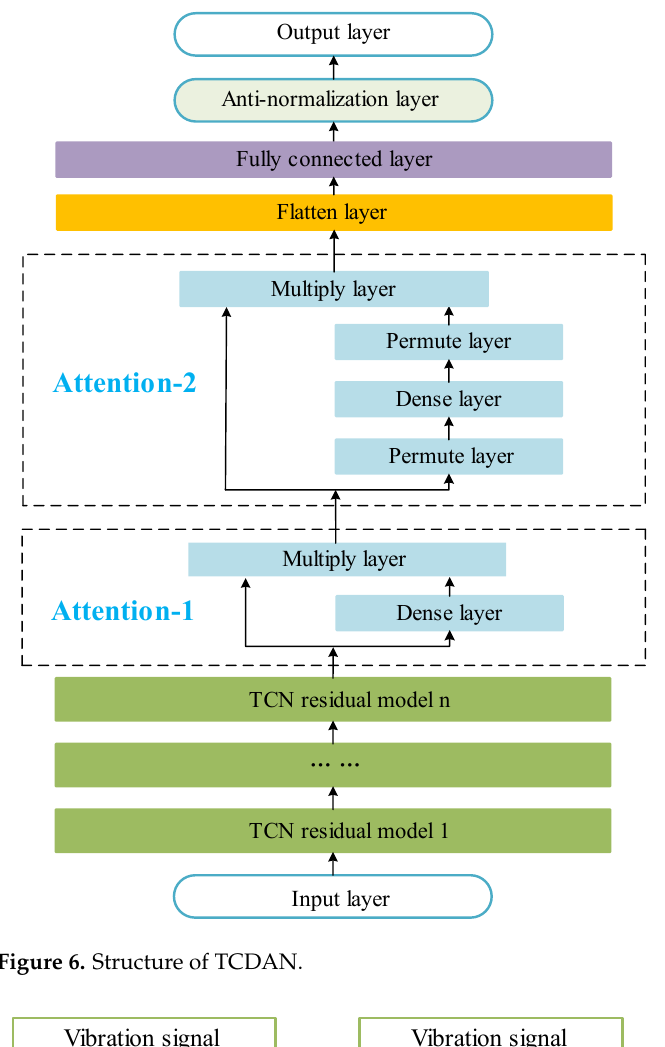
Figure 6. Structure of TCDAN.